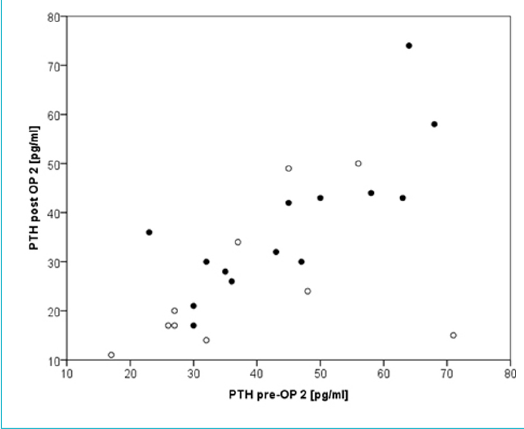
Figure 1: Correlation between pre- and postoperative parathyroid hormone (PTH) showing strong correlation (r = 0.802, p = 0.001) only in normocalcaemic group (group 2, filled